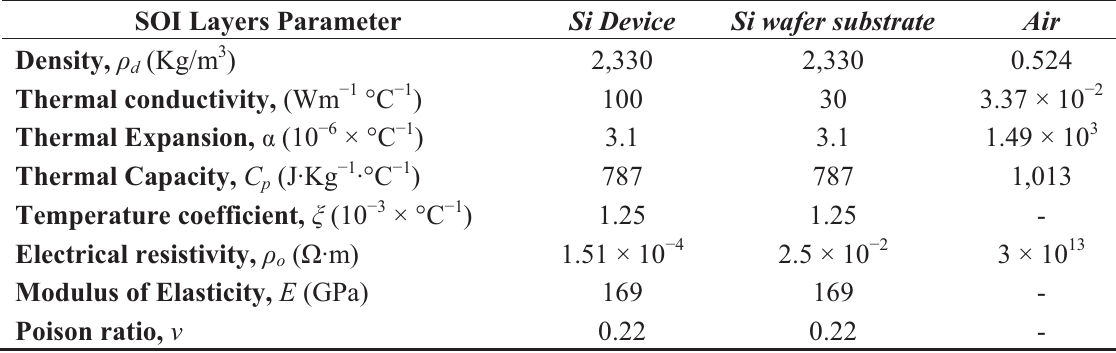
Table 1. Material properties of SOI actuators.